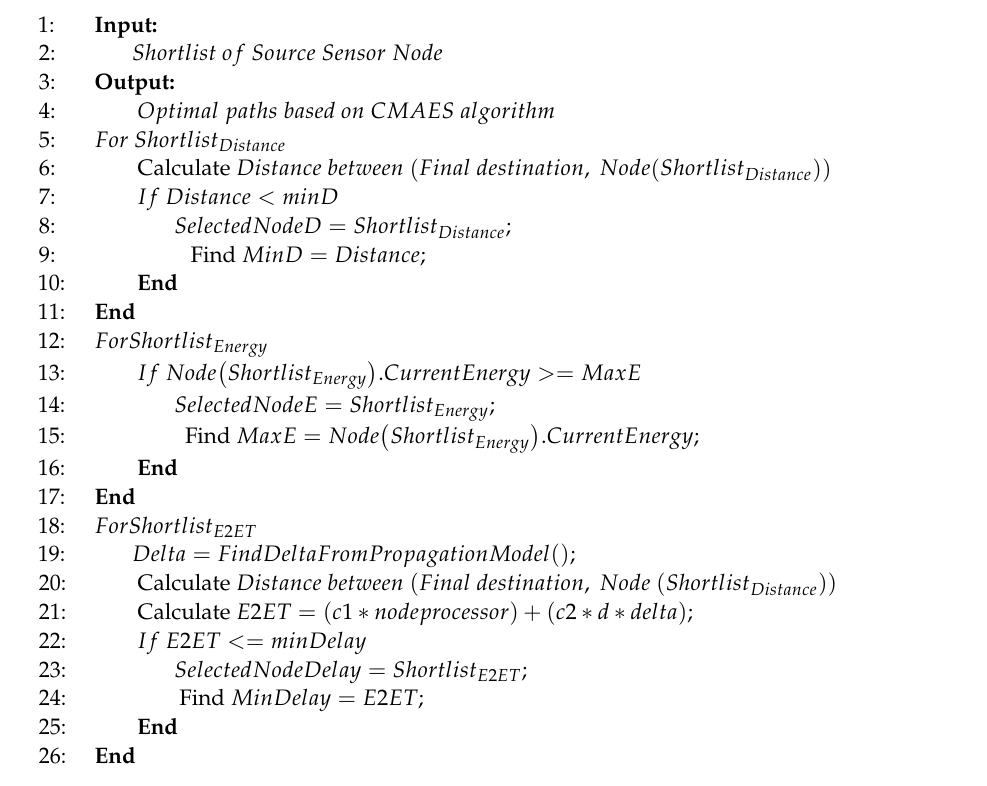
Algorithm 1: Objective Functions of Select the Best Paths of Graph Routing algorithms based on of